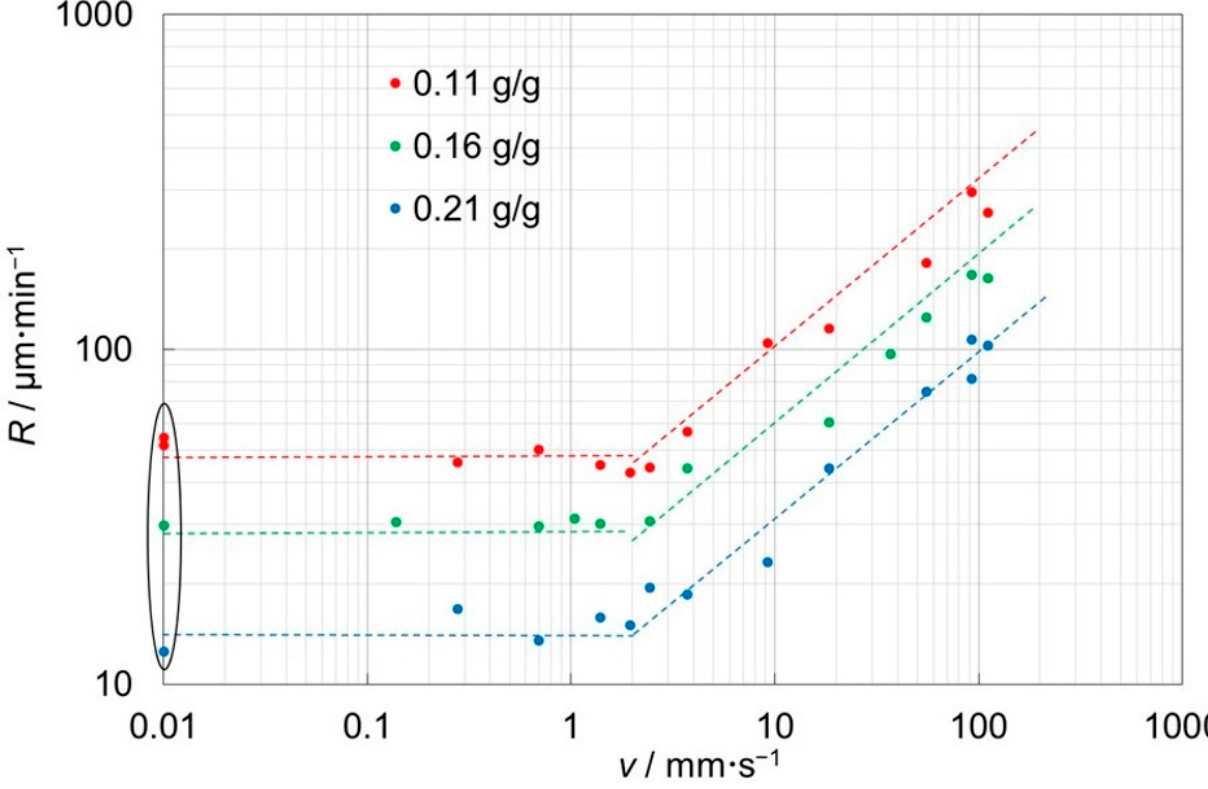
Figure 9. Face displacement velocity of the (110) glycine facet under forced convection. Values at stagnant flow (oval marking) are plotted at v = 0.01 mm/s to show them in the logarithmic